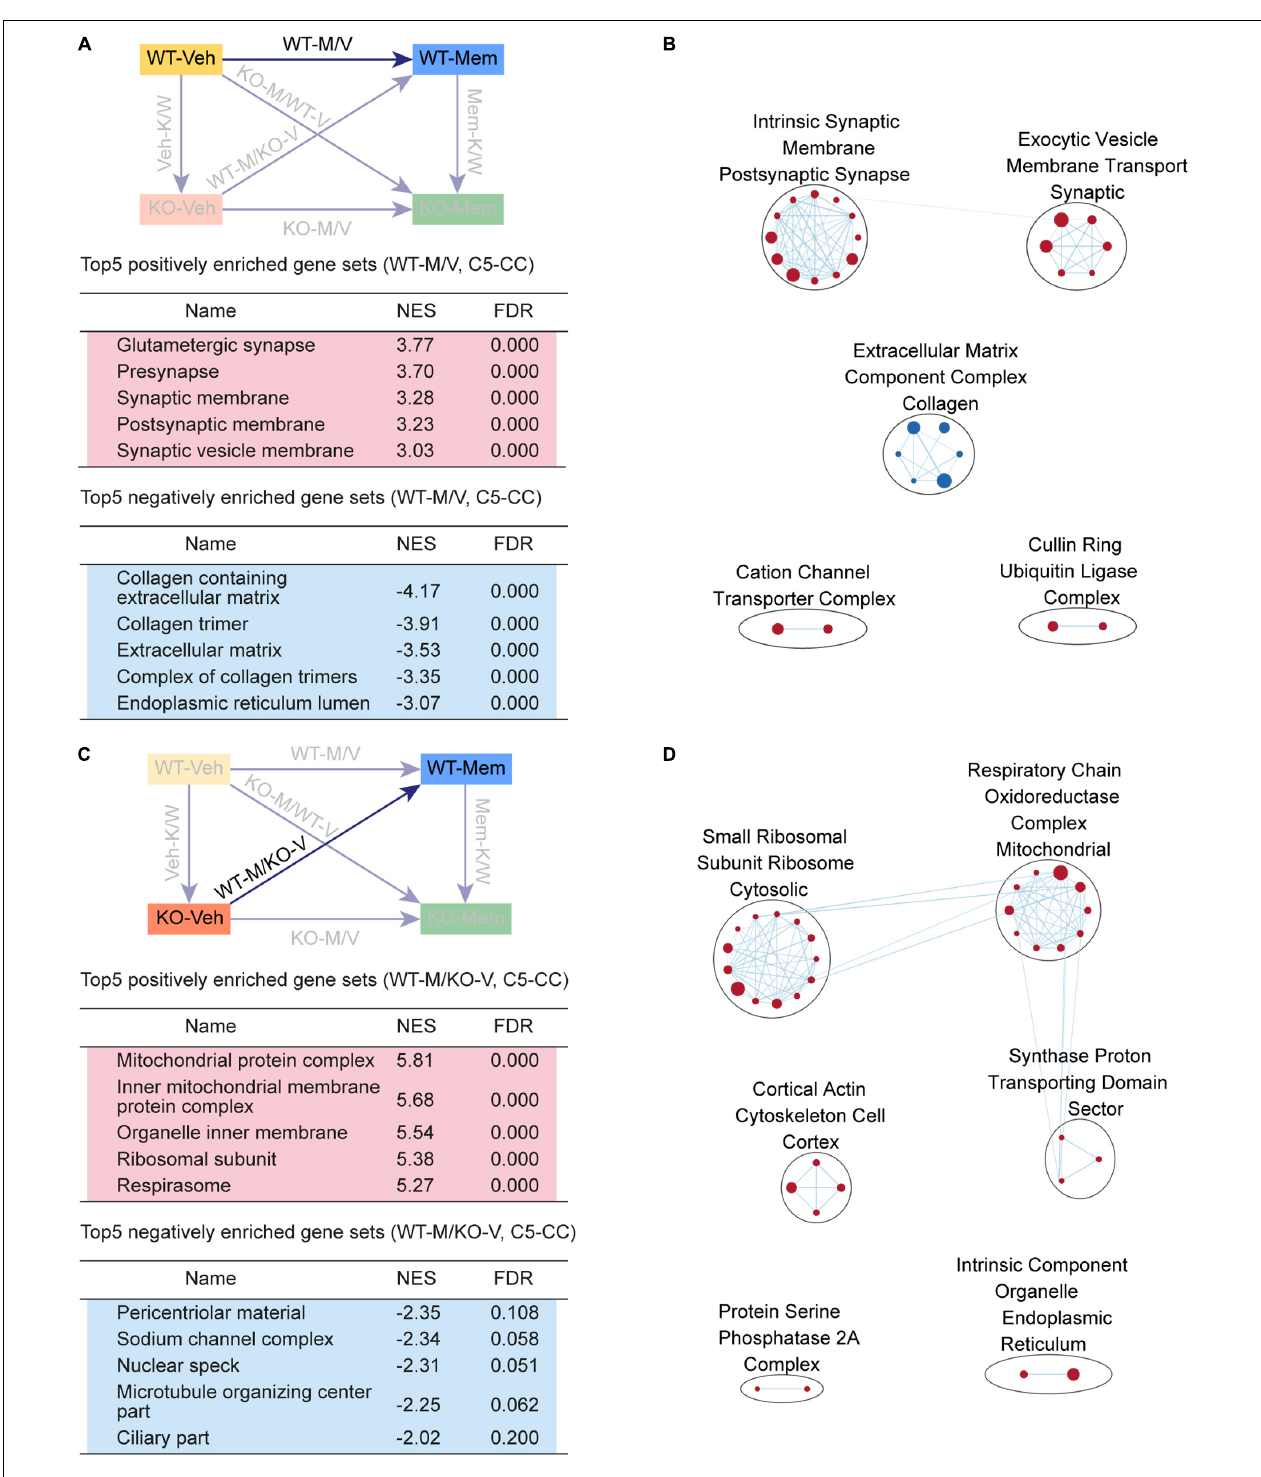
FIGURE 5 | Gene Set Enrichment Analysis of WT-M/V and WT-M/KO-V transcripts for biological functions. (A,B) GSEA results for WT-M/V transcripts showing a list of the top five positively (red) and negatively (blue) enriched gene sets in the C5-CC domain (A) and their integrated visualization generated using EnrichmentMap (B) . See Supplementary Figure 5 for GSEA C5-BP/MF results. [ n = 3 mice (WT-Veh, WT-Mem), FDR < 0.05]. (C,D) GSEA results for WT-M/KO-V transcripts showing a list of the top five positively (red) and negatively (blue) enriched gene sets in the C5-CC domain (C) and their integrated visualization generated using EnrichmentMap (D) . See Supplementary Figure 6 for GSEA C5-BP/MF results. [ n = 3 ice (WT-Mem, KO-Veh), FDR <